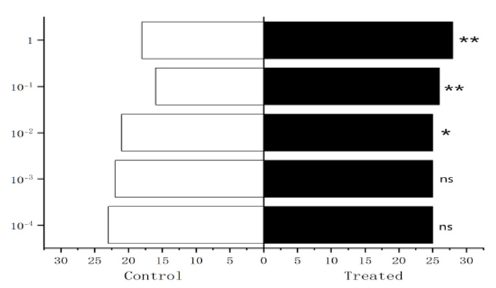
Figure 27. Behavioral responses to methylheptenone in male W. magnifica . Note: ns: no significant difference ( p > 0.05); *: significant difference (0.01 < p < 0.05); **: extremely significant difference ( p < 0.01); x -axis: sample grouping; y -axis: sample concentration. The same below.